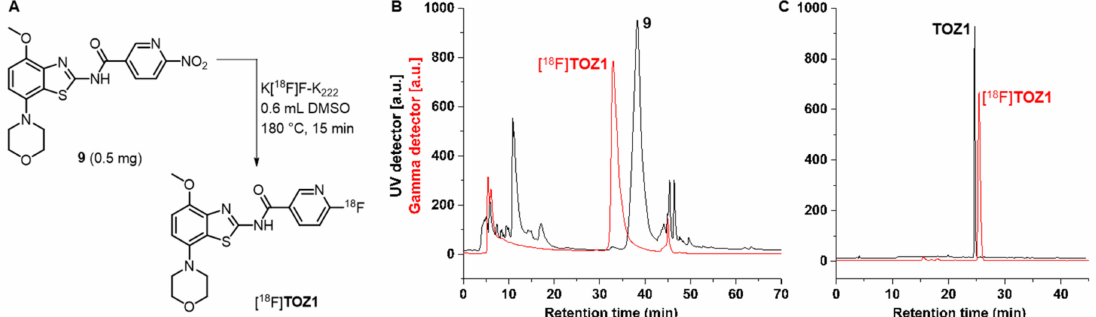
Figure 5. ( A ) Radiosynthesis of [ 18 F] TOZ1 by radiofluorination of the nitro precursor 9 . ( B ) Representative radio- and UV-chromatograms obtained for the isolation of [ 18 F] TOZ1 by semi-preparative reversed-phase (RP)-HPLC (ReproSil-Pur 120 C18-AQ (250 × 10 mm), 36% acetonitrile (MeCN)/H 2 O/0.05% trifluoroacetic acid (TFA), flow rate: 4 mL/min); and ( C ) radio- and UV-chromatograms of formulated [ 18 F] TOZ1 co-injected with the corresponding reference compound TOZ1 (ReproSil-Pur 120 C18-AQ column (250 × 4.6 mm), 10-90-10% MeCN/20 mM NH 4 OAc aq. flow rate: 1